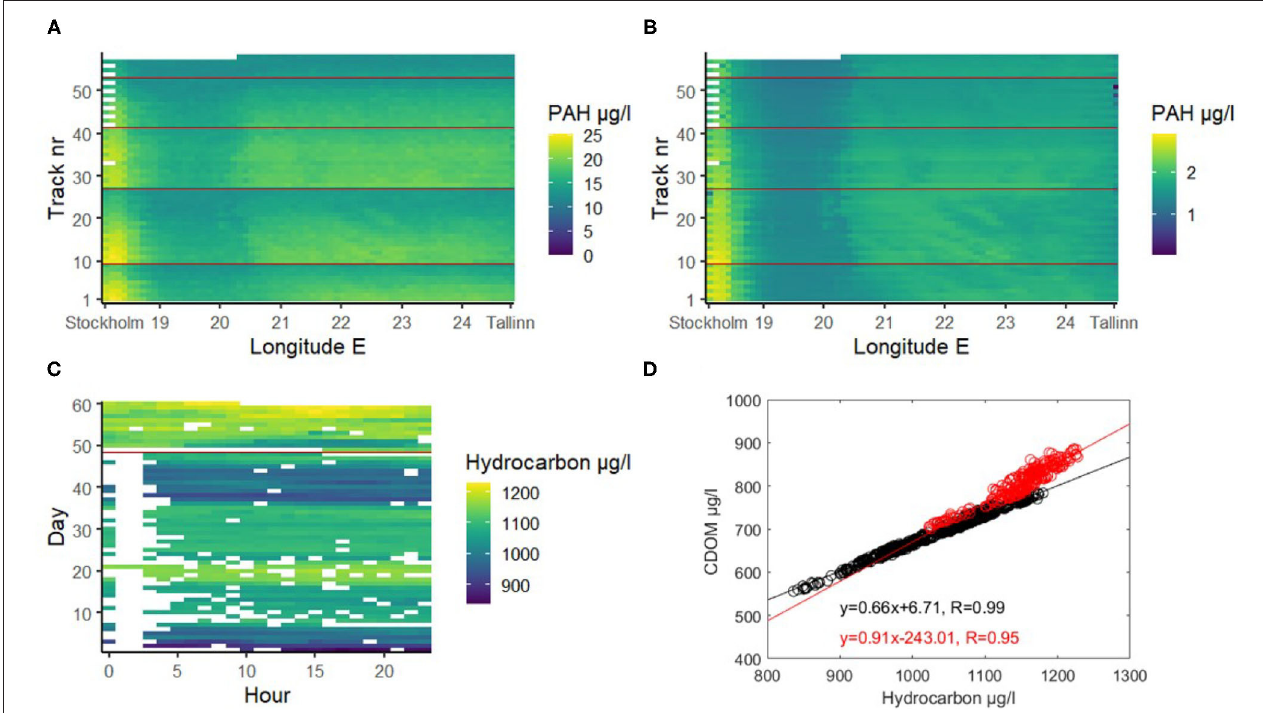
FIGURE 9 | Heatmap plots showing spatiotemporal distributions of PAH concentrations in seawater along the ship track between Stockholm and Tallinn (February 21 to April 21, 2018) measured with the UviLux (A) and EnviroFlu-HC (B) fluorometric sensors. A temporal heatmap of the SmartBuoy data (October 25 to December 24, 2018) (C) and correlation between CDOM and hydrocarbon data before (black) and after (red) the maintenance (D) . Red lines on the heatmaps indicate system maintenance